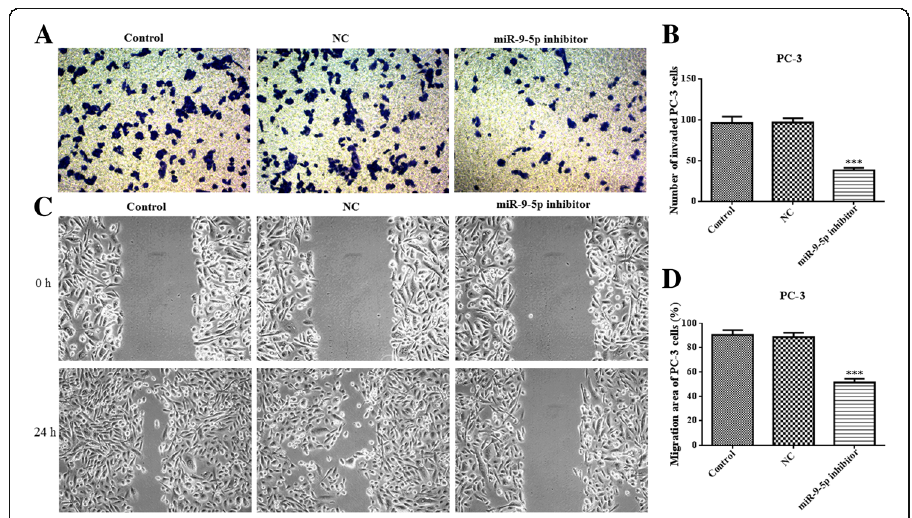
through d - PC-3 cells were transfected with the miR-9-5p inhibitor and cell migration was assessed using the wound-healing assay. *** p < 0.001 vs. NC group. All experiments were performed with at least